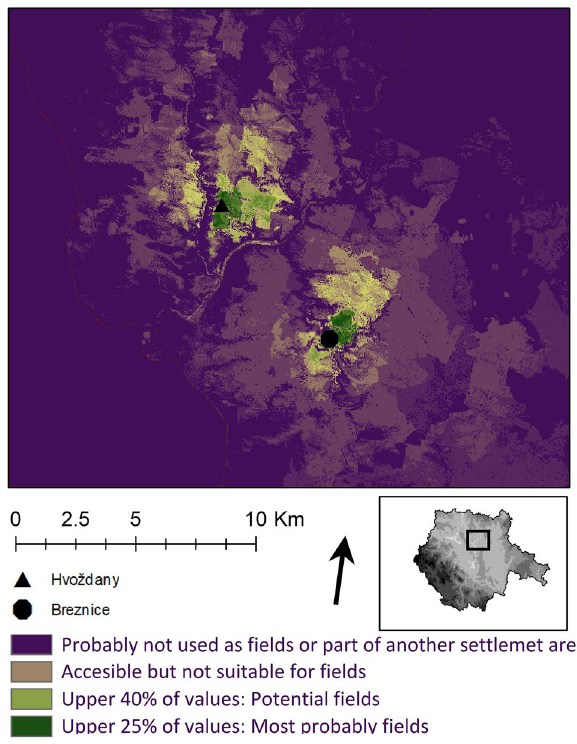
Figure 6. Březnice and Hvožďany: a model of suitability for fields used in the prediction of the optimal area for the agricultural hinterland of the site is based on Evaluated Soil Ecological Units 86 , von Thunen SCA analysis 81 , slope and cost raster 90 . Prediction was modelled in ArcGIS 1.7 (licensed to USB) based on Digital elevation model data (https:// ags. cuzk. cz/ arcgi s2/ rest/ servi ces/ dmr5g/ Image Server). Site catchements 81 according to the walk distances 83 are shown hatched.